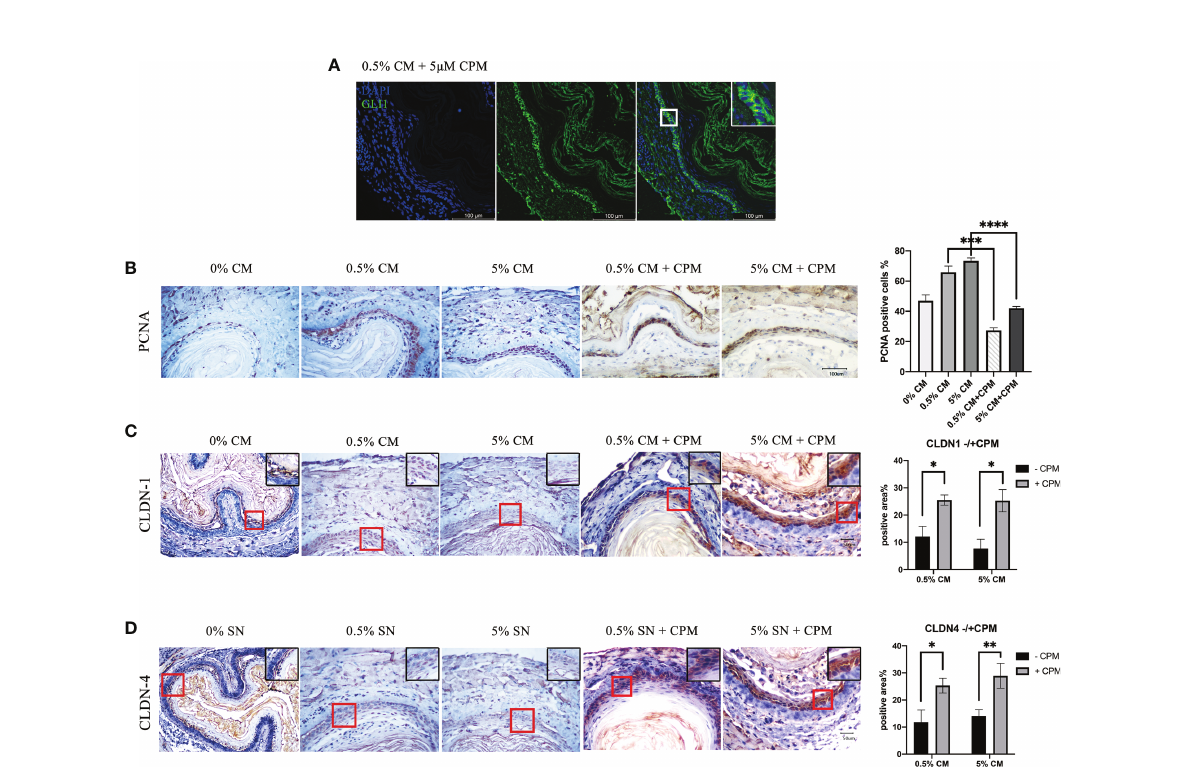
FIGURE 5 SHH inactivation reduced the percentage of PCNA-positive cells, which was increased in esophagi by P. gingivalis cultured media treatment, and recovered the expression of tight junction markers. (A) Predominately cytoplasmic localization of GLI1 in mouse esophageal epithelial cells cultured in CPM-supplemented medium. (B) Percentages of PCNA-positive cells in 0.5% CM and 5% CM groups were signi fi cantly decreased when CPM was added. (C) CLDN1 expression was decreased in 0.5% CM and 5% CM groups and was increased back to normal in the esophageal epithelium with the addition of CPM. (D) Accumulation of CLDN4 in esophageal epithelial cells in the presence of CPM, compared with culture without CPM. Scale bars: 100 m m (A) ; 50 m m (B – D) . * P < 0.05; ** P < 0.01; *** P < 0.001; **** P <